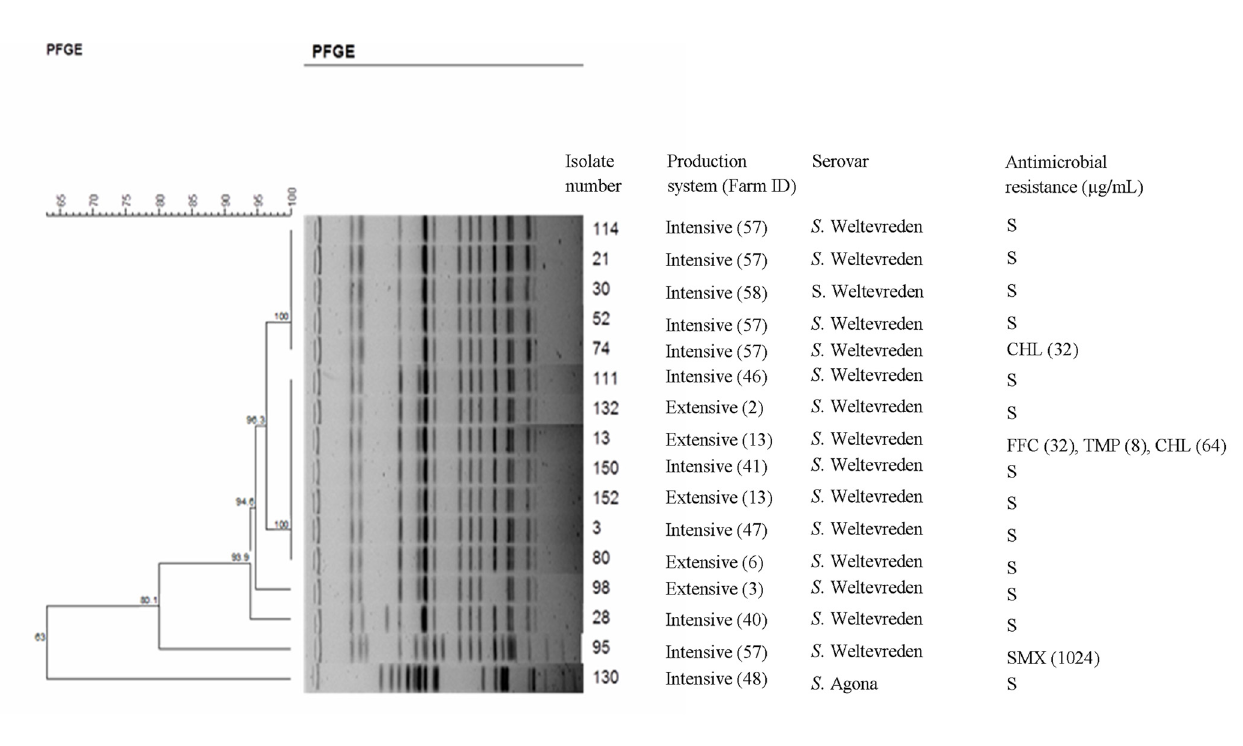
Fig 1. Xba I PFGE patterns and antimicrobial susceptibility of Salmonella isolates from shrimp samples from intensive and extensive production system. Similarity analysis was performed using the Dice coefficient, and clustering was done by the unweighted pair-group method with arithmetic averages (UPGMA; position tolerance 1.0%). Antimicrobial resistance was determined using the Sensititre Vizion System and MIC values were evaluated in accordance with the protocol of the Clinical and Laboratory Standards Institute. FFC, Florfenicol; CHL, Chloramphenicol; SMX, Sulfamethoxazole and TMP, Trimethoprim; "S" means susceptible to all antimicrobials tested. MIC values ( μ g/mL) are shown in brackets.